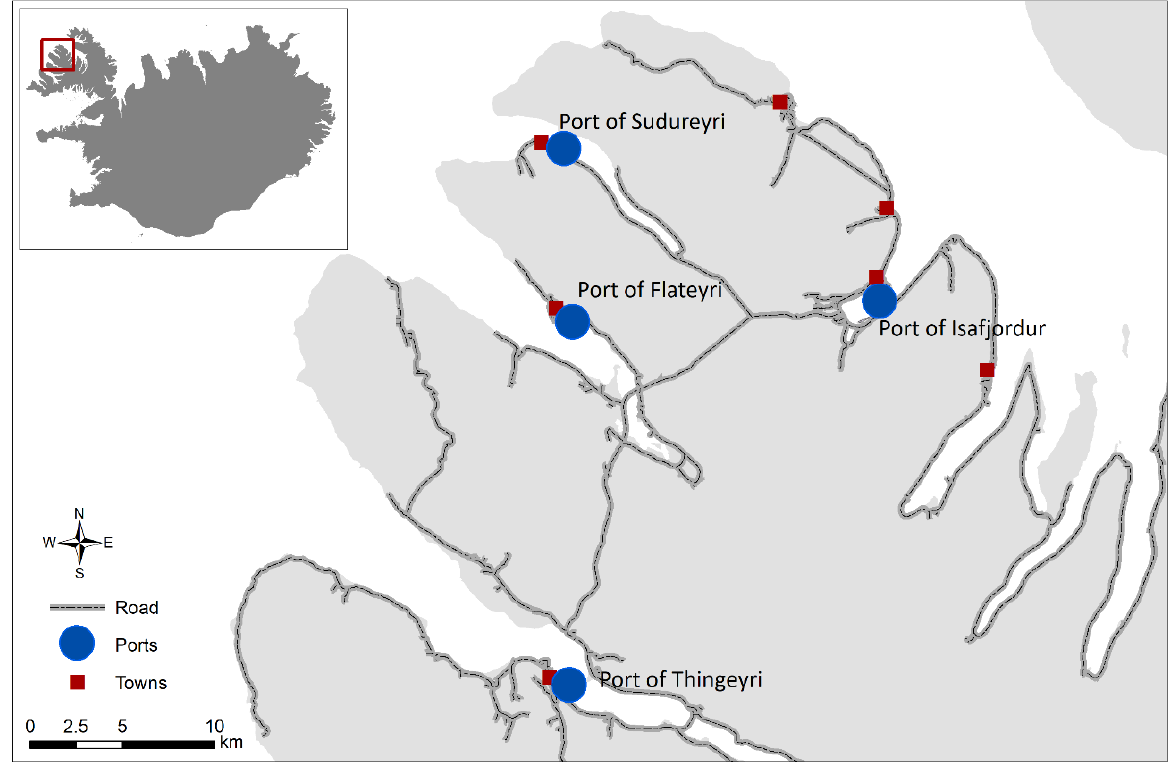
Figure 3. The location of the ports. The study area is depicted on the map of